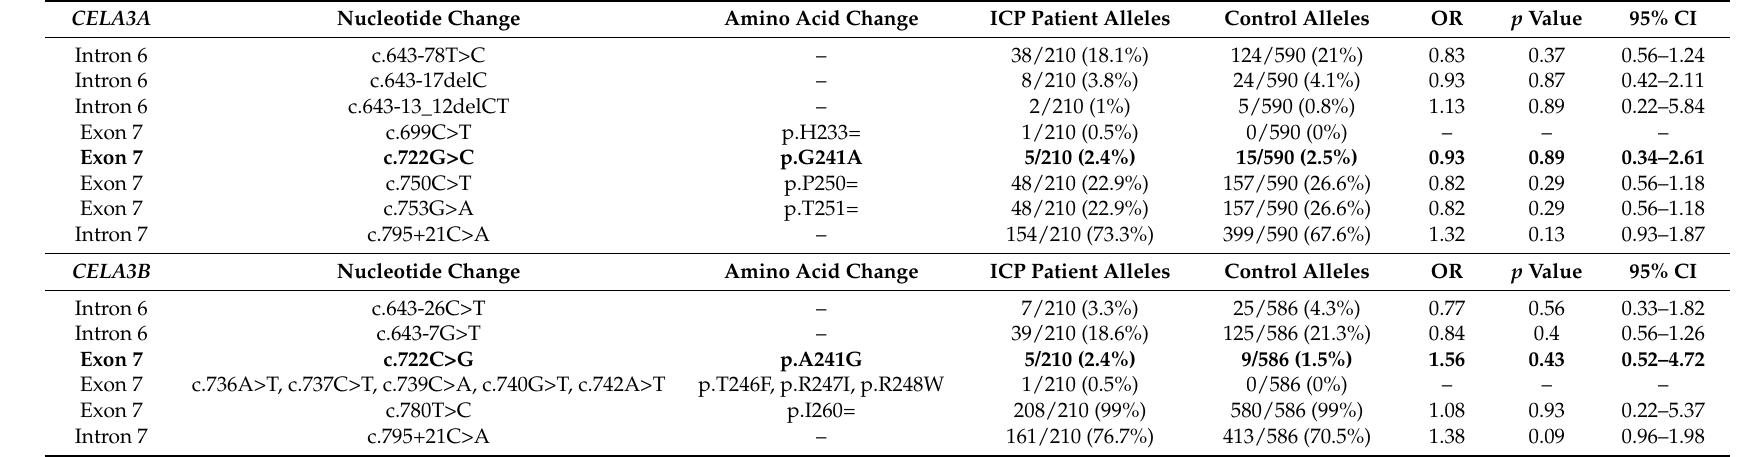
Table 3. Allele frequency of CELA3A and CELA3B variants in patients with idiopathic chronic pancreatitis (ICP) and controls without pancreatic disease. Variants affecting position 241 are highlighted in bold. OR, odds ratio; CI, confidence